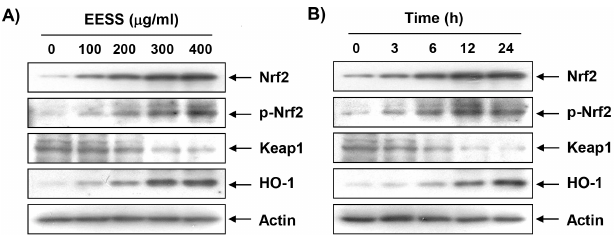
Figure 5. Induction of Nrf2 and HO-1 by EESS in SW1353 chondrocytes. Cells were treated with ( A ) the indicated concentrations of EESS for 24 h; or ( B ) 400 μ g/mL EESS for the indicated times. The cells were lysed, and cellular proteins were separated by SDS-polyacrylamide gel electrophoresis, and transferred to membranes. The membranes were probed with the indicated antibodies. Proteins were visualized using an ECL detection system. Actin was used as an internal control.